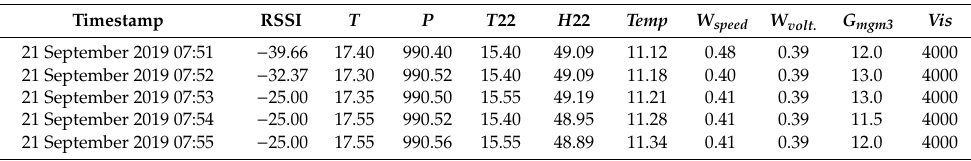
Table 1. Example of data set preprocessing.